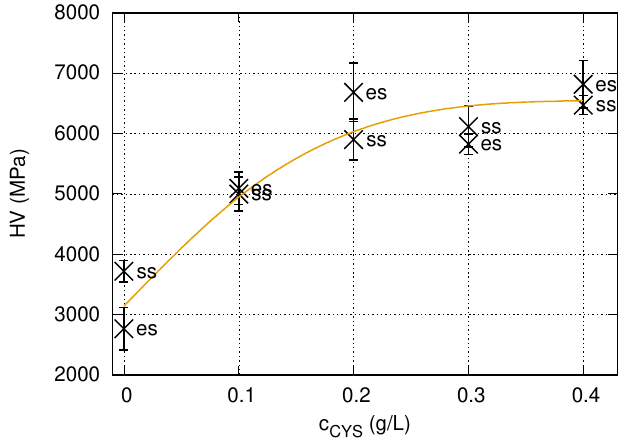
Figure 6. The Vickers hardness (HV) as a function of the cysteine content in the bath for the “es” and “ss” sides of the Ni films. The line serves as a guide for the eye